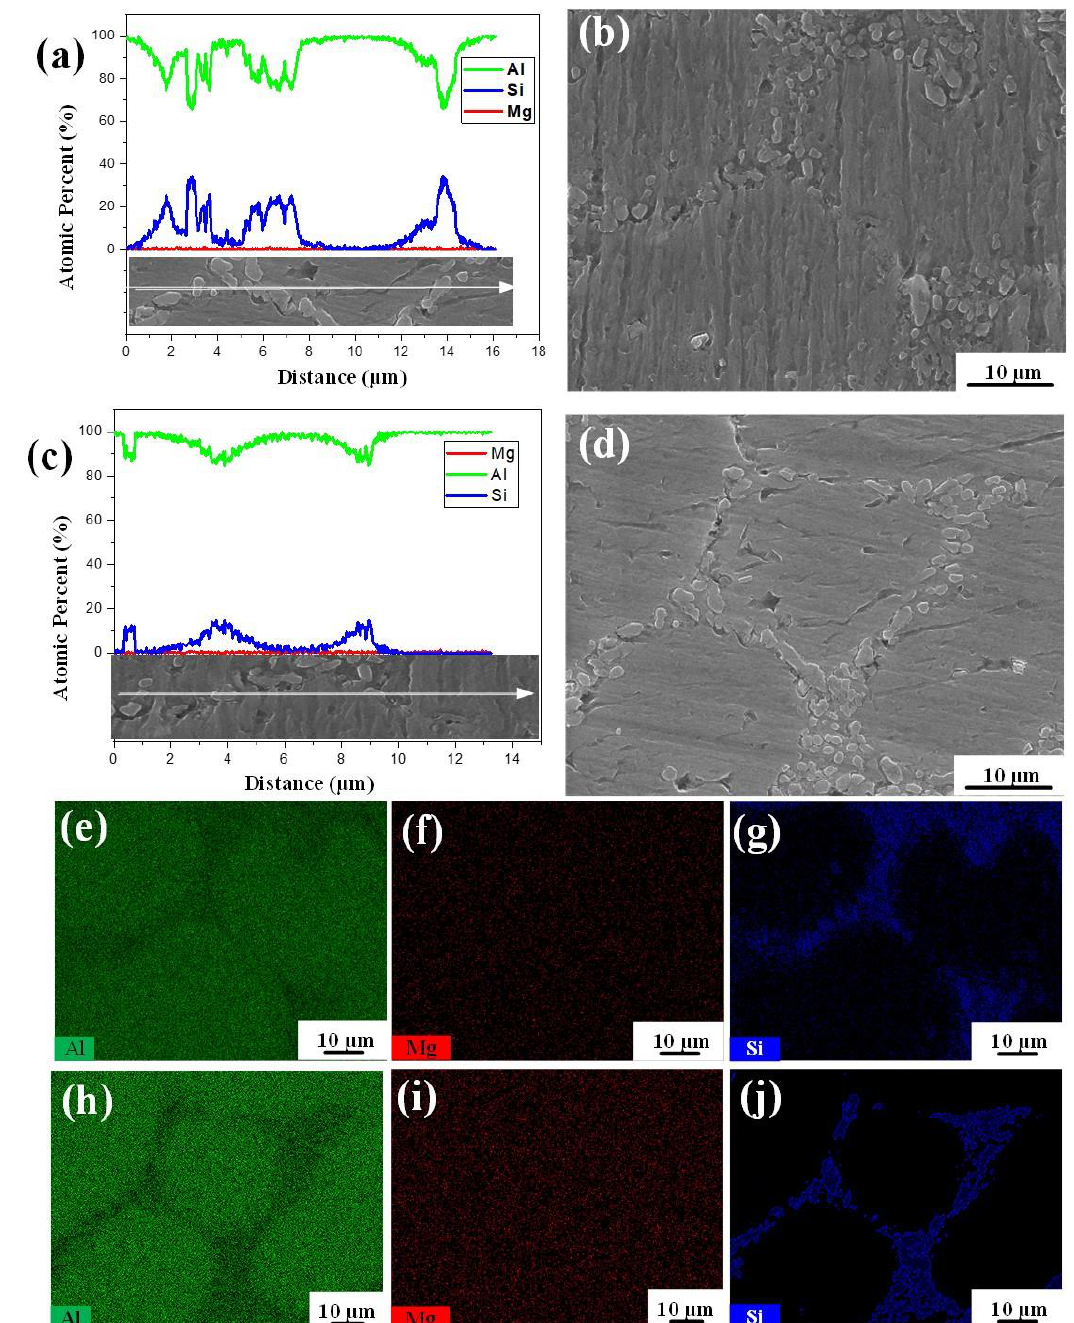
Figure 4. EDS results for different regions: ( a ) UZ line scan results; ( b ) UZ SEM image; ( c ) CCZ line scan results; ( d ) CCZ SEM image; ( e – g ) Al, Mg, and Si distribution of UZ; and ( h – j ) Al, Mg, and Si distribution of CCZ.